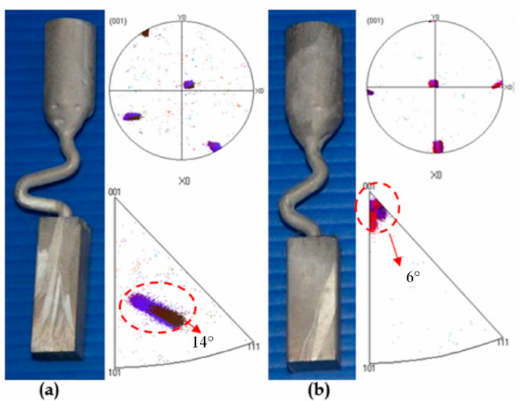
Figure 3. Pole figures of two cases with di ff erent take-o ff angles: ( a ) θ = 15 ◦ ; ( b ) θ = 40 ◦ . The take-o ff angle also influences the deflection angle to < 001 >